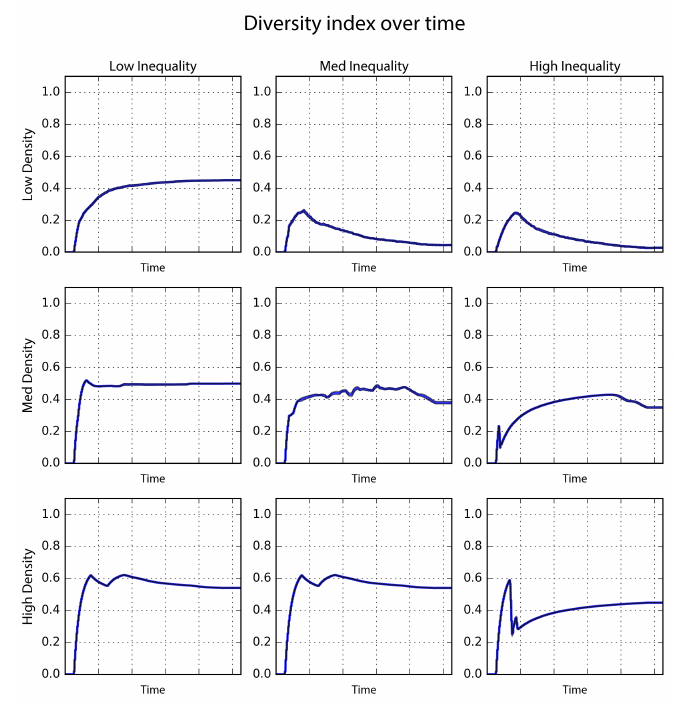
Figure 12. Time series of the diversity indicator values produced by the model when parameterized with varying combinations of low, medium, and high density and inequality values. The mean value across 50 runs is blue and the gray lines depict the 95% confidence